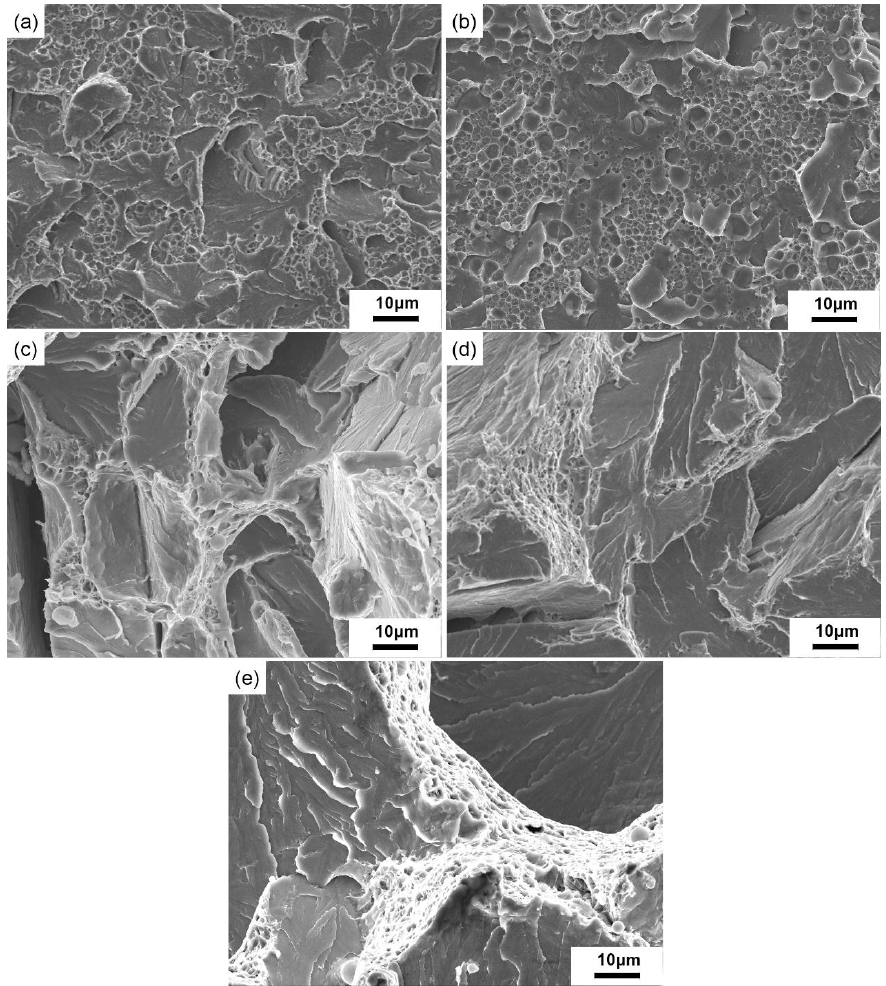
Figure 12. The SEM impact fracture of SA 508–3 under different temperatures when the reduction ratio was 20% ( a ) at 850 °C, ( b ) at 950 °C, ( c ) at 1050 °C, ( d ) at 1150 °C, and ( e ) at 1200 °C. was 20% ( a ) at 850 ◦ C, ( b ) at 950 ◦ C, ( c ) at 1050 ◦ C, ( d ) at 1150 ◦ C, and ( e ) at 1200 ◦